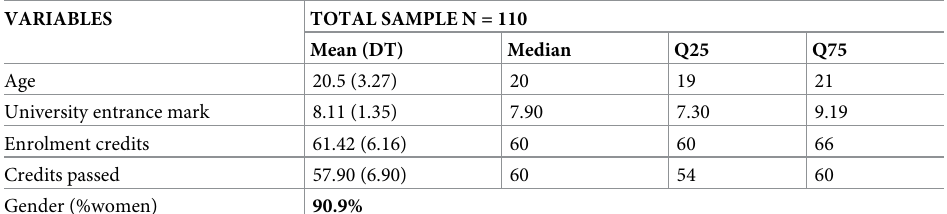
Table 1. Description of the variables of gender, age, university entry mark and credits passed up to the time of the global sample.